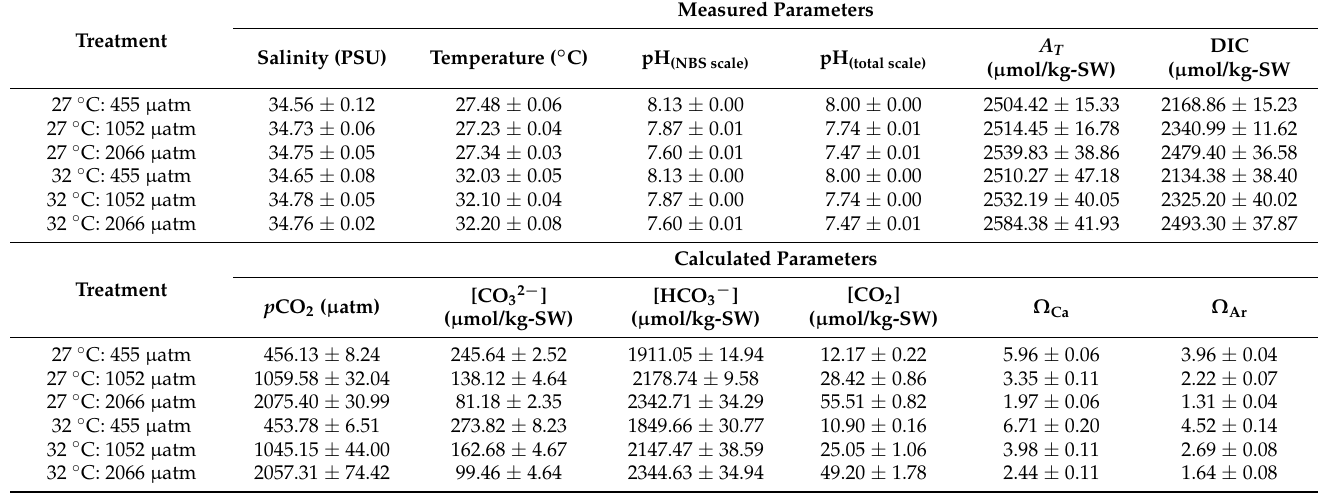
Table 1. Seawater chemistry values measured during a 90-day experimental period for A. yairi reared under two temperature levels (27 ◦ C and 32 ◦ C) crossed with three levels of p CO 2 (455 µ atm, 1052 µ atm, and 2066 µ atm). A T , total alkalinity; DIC, dissolved inorganic carbon; p CO 2 , partial pressure of CO 2 ; [CO 32 − ], carbonate ion concentration; [HCO 3 − ], bicarbonate ion concentration; [CO 2 ], dissolved CO 2 ; Ω Ca , calcite saturation state; Ω Ar , aragonite saturation state. Data are presented as mean values ±